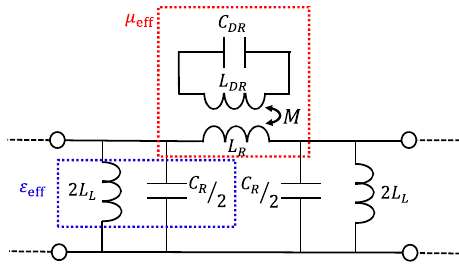
Fig. 2. Equivalent circuit model for the unit cell including dielectric particles under magnetic dipole like resonance and metallic mesh structure operating as negative epsilon below-the cut-off